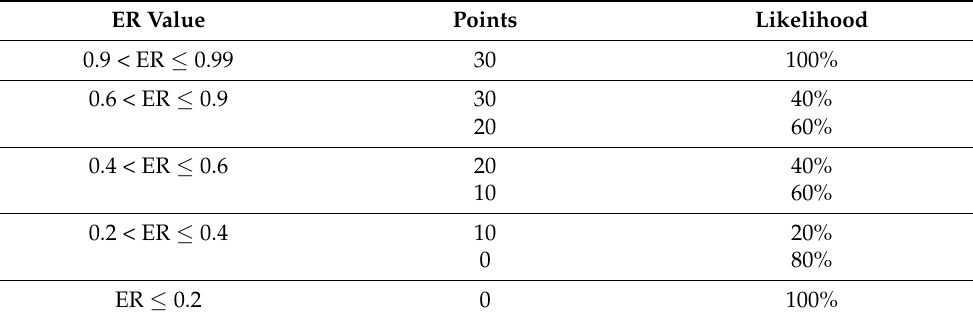
Table 1. Score likelihood for the SkeeBall game as a function of the calculated extensor ratio